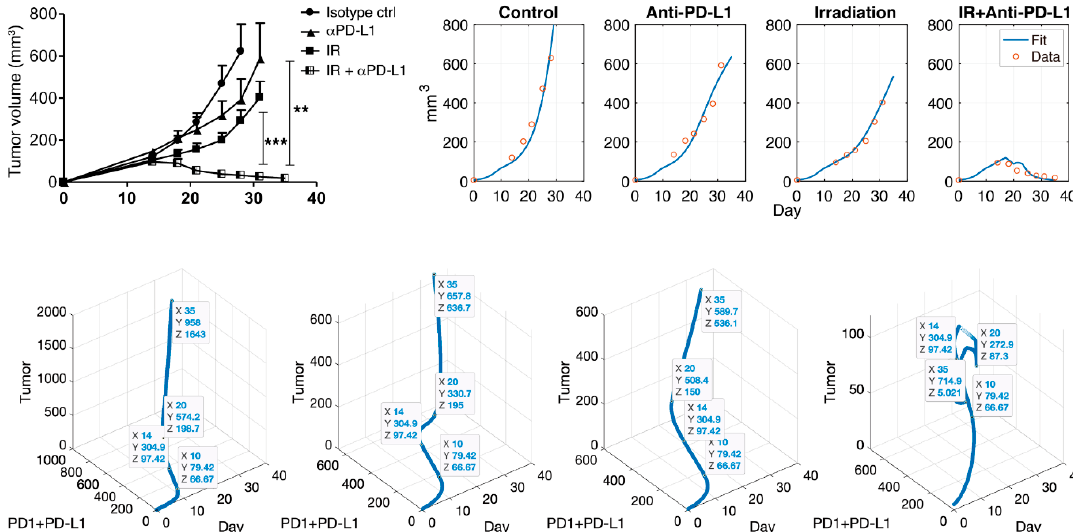
Figure 2. Note that α PD-L1 is IT (anti-PD-L1). Deng et al. showed the synergistic effect of combination therapy (top left). Simulation results (top right) after data fitting are presented through the mathematical model. This model captures the control, IT, and IR well, and this model also fits combination therapy. The blue curve indicates data fit using the Equations (1)–(6), and the red circle is experimental data. A scatter plot is shown for tumor vs. PD-1 + PD-L1 vs. day (bottom). Each figure indicates control, IT, IR, and the combination of IR and IT in turn. Data tips are marked on day 10 (before therapy), 14 (beginning of IR and IT therapy), 20 (during IT therapy), and 35 (final timepoint). The sum of PD-1 and PD-L1 does not always positively correlate with tumor size after therapy. The coordinates X, Y, and Z, as shown in bottom figure, represent days, PD-1 + PD-L1 concentration and tumor size, respectively. **: p < 0.01; ***: p < 0.001. In the control case, tumor size, PD-1 and PD-L1 expression were positively exponentially 11.45𝑒 (cid:2868).(cid:2868)(cid:2868)(cid:2873)(cid:2870)⋅(cid:3047) with 𝑅 (cid:2870) = 0.9975. Cases were compared before and after therapy. Before therapy, the